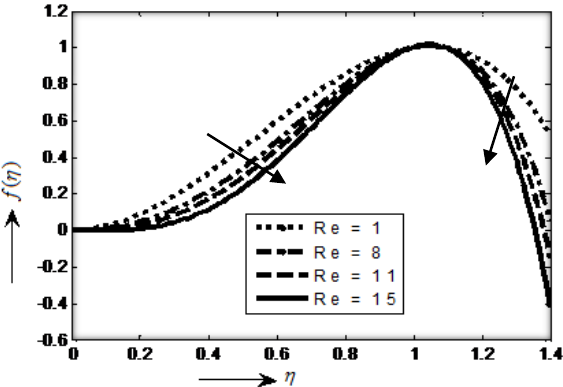
Figure 15. Variation of fluid velocity f (  ) against  for Reynolds numbers Re (1, 8, 11, 15) by taking parameters M =0, K = 0 and  = 0.05